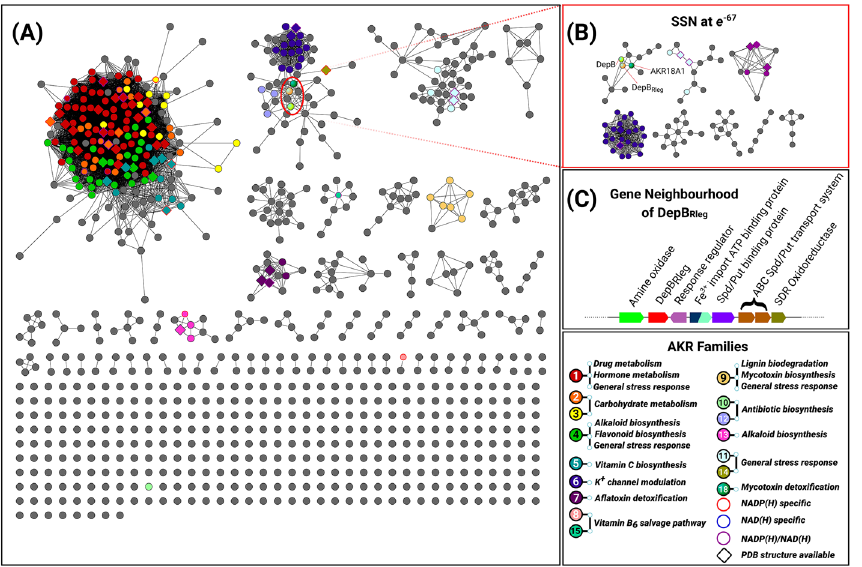
Figure 2. A 40% representative sequence similarity network (SSN) at a threshold of e −57 . ( A ) Nodes within each cluster contain a representative protein sequence of a collection of sequences that share 40% or more sequence identity. Clusters have been annotated and color-coded based on curated protein sequences from the AKR Database 21 . Grey nodes represent AKRs that have no functional annotation. Metabolic pathways associated with the function of AKR enzymes have been color-coded to cross-reference with each cluster and numerically labeled to designate each AKR family number. The nodes of AKRs possessing biochemical data on coenzyme specificity and crystal structures have also been accordingly labeled as outlined in the legend. ( B ) SSN generated at a threshold of e −67 depicting complete segregation of the AKR18 family from AKR6, AKR12 and AKR14 members. ( C ) Genome Neighborhood Diagram of DepB Rleg. The GND was generated using the EFI-GNT server which depicts the coding sequence region of depB Rleg along with putative functions of upstream and downstream